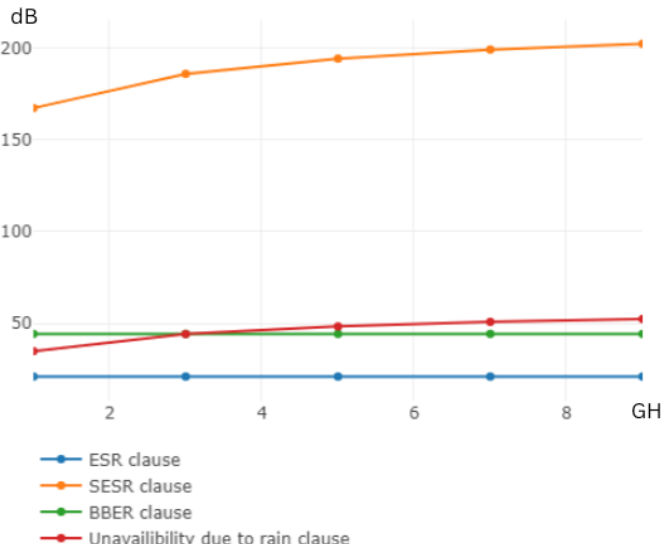
Figure 7. Critical margin window